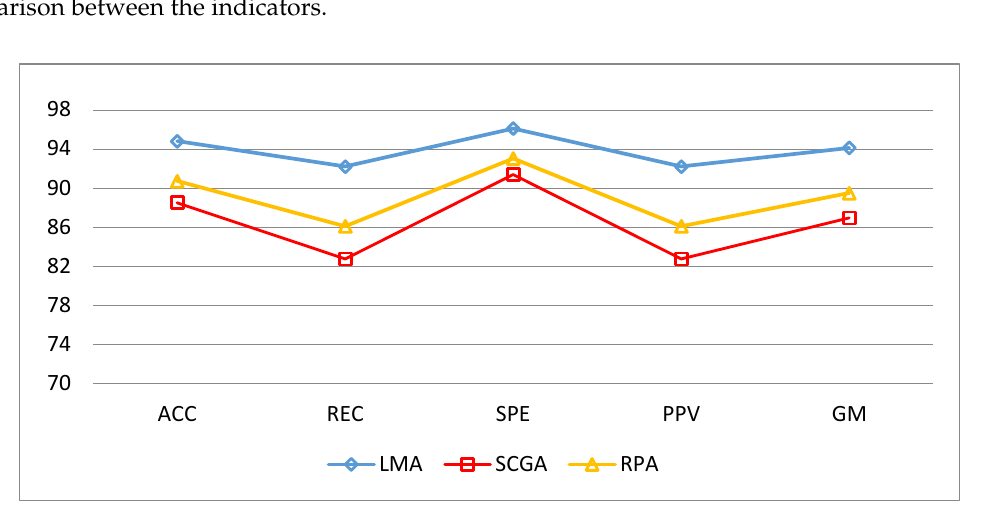
Figure 9. Five classification parameters of comparison in three algorithms.